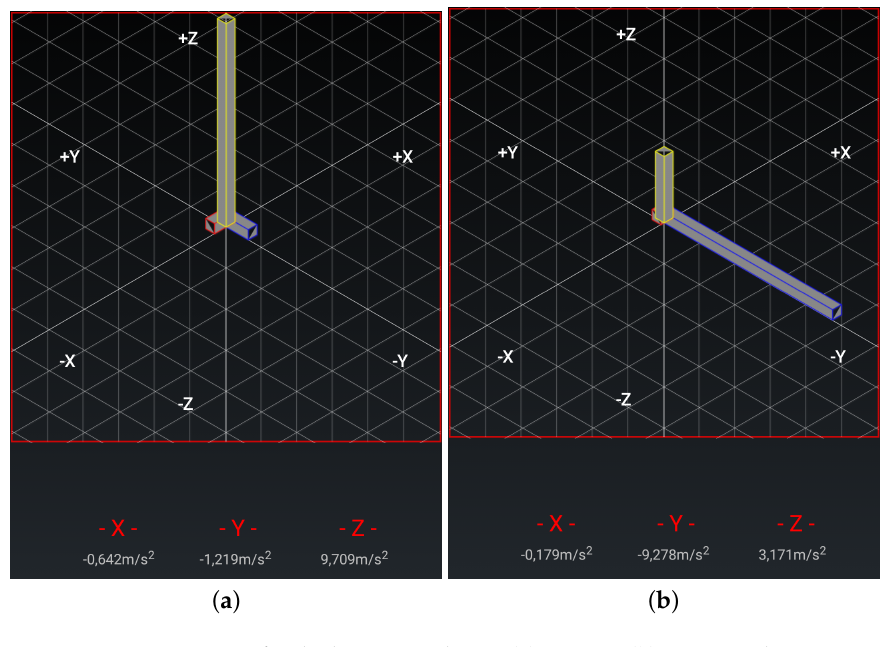
Figure 4. Gravity for the legs strength test: ( a ) User sit; ( b ) User standing.